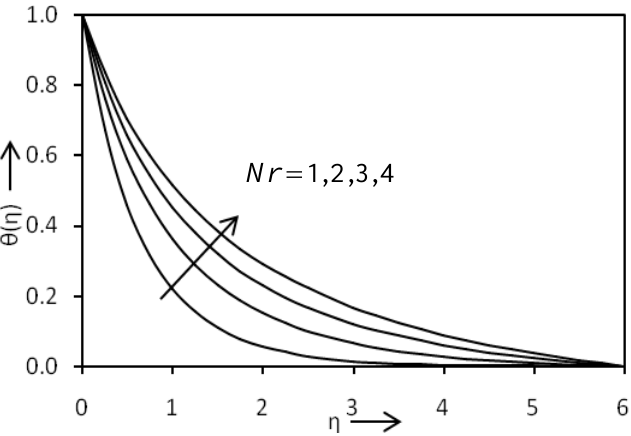
Figure 8. Variation of N r on the temperature profiles